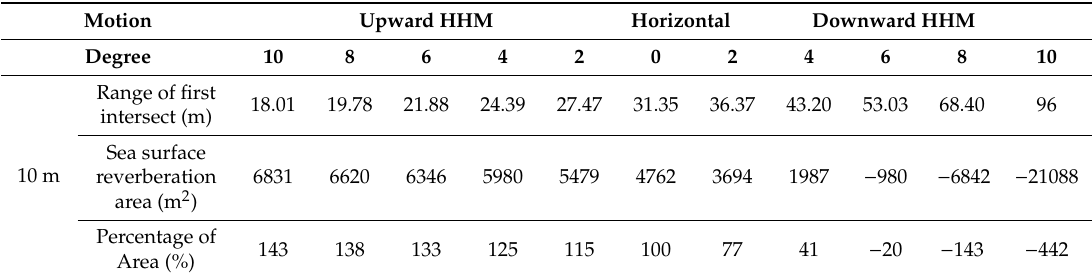
of the sonar image, and the sonar scanning angle was represented by a red line. The blue background image at the bottom shows the brightness of the sonar pixels divided into 0 to 255 color distributions. A radial pattern noise on the surface of the water can be seen, and it was also confirmed that the red color with the highest color intensity was concentrated on the seabed near the CR200 in the image with ◦ the 10 downward HHM applied (right image). It shows the improvement e ff ect of the sonar image for the three di ff erent